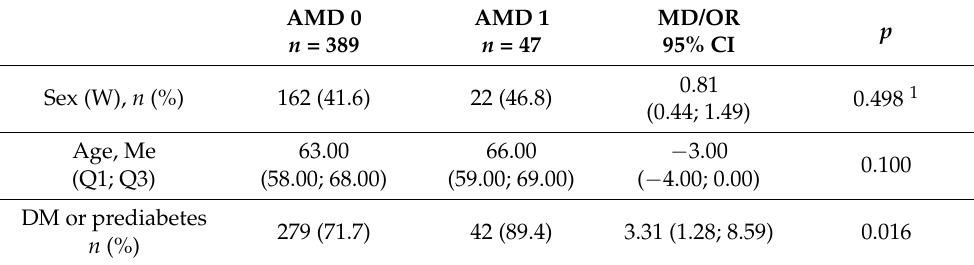
Table 1. Demographic characteristics of the sample by AMD diagnosis.